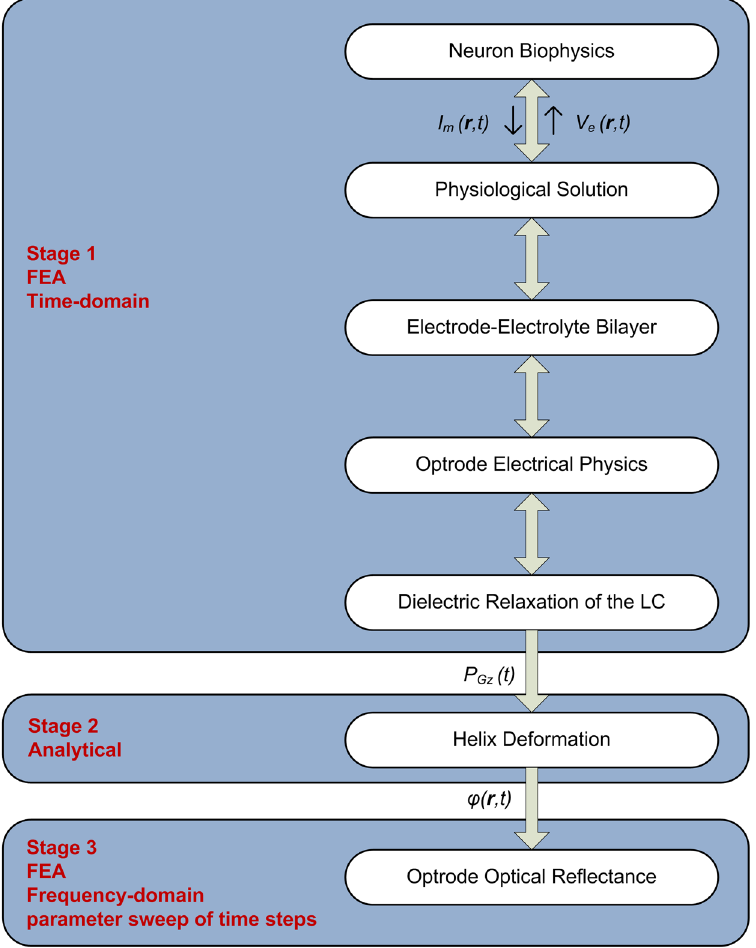
Figure 3. Flow chart of pipeline used to model the optrode device’s operation. Stage 1: the neuronal biophysics was fully coupled to the electrical physics of the device and physiological solution, including Debye formulations for the dielectric relaxation of the liquid crystal (LC) and electrode-electrolyte bilayers. Finite element analysis (FEA) was performed in the time-domain. Stage 2: The azimuthal angle ( ϕ ( r , t )) for the LC helix deformation was analytically calculated from the polarisation of the LC in the electric field direction P Gz ( t ). Stage 3: For each ϕ ( r ) a frequency domain FEA was used to calculate the optrode’s reflectance at each instance ( t ). By sweeping through the time points, change in reflectance with time was simulated. Note that r denotes the global Cartesian coordinates.